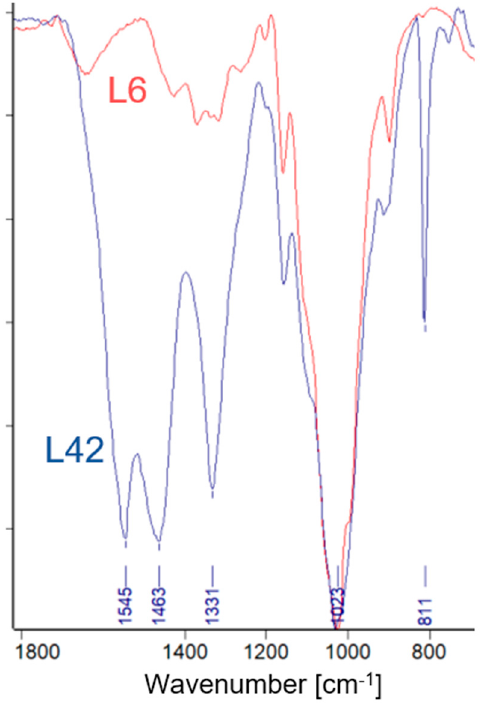
Figure 5. FTIR spectra of the backing layers of L6 and L42. The absorption at 811 cm − 1 represents melamine. The backing layer of L6 shows no signs of melamine and consists primarily of pure cellulose.